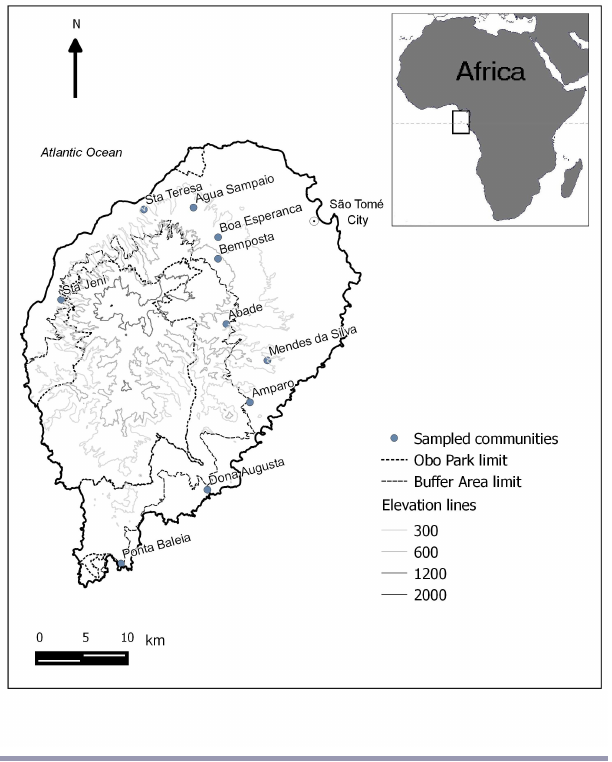
Fig. 1 . Location of sampled communities on São Tomé Island. The rectangle on the inset shows the location of the island off the west coast of